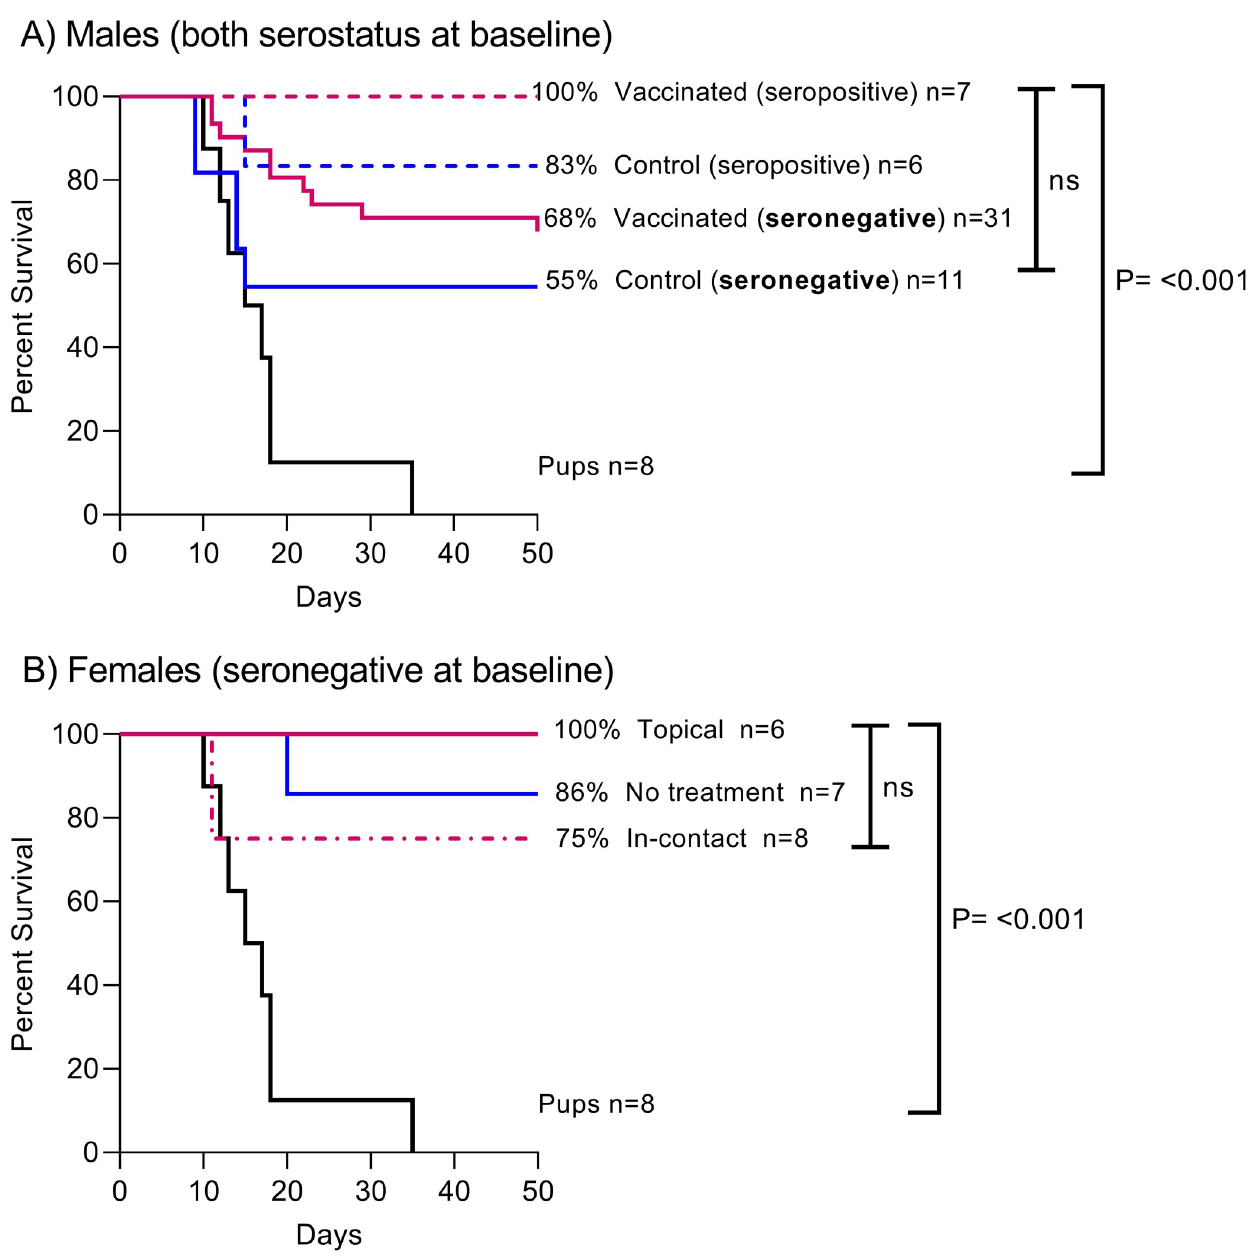
Fig 2. Kaplan-Meier analysis of vampire bat survival after challenge with a heterologous RABV strain and observation for 50 days post-challenge in A) male bats grouped by initial serostatus (seropositive/seronegative) and treatment received (vaccinated orally and topically, or control, RCN- luc ), and B) female bats, seronegative-at-baseline and grouped by treatment received (vaccinated topically, in-contact, or no treatment). Eight captive-born pups were considered RABV na ï ve controls. A P value of < 0.05 was set as significant and “ns” indicates no significance. The numbers of animals in each group are